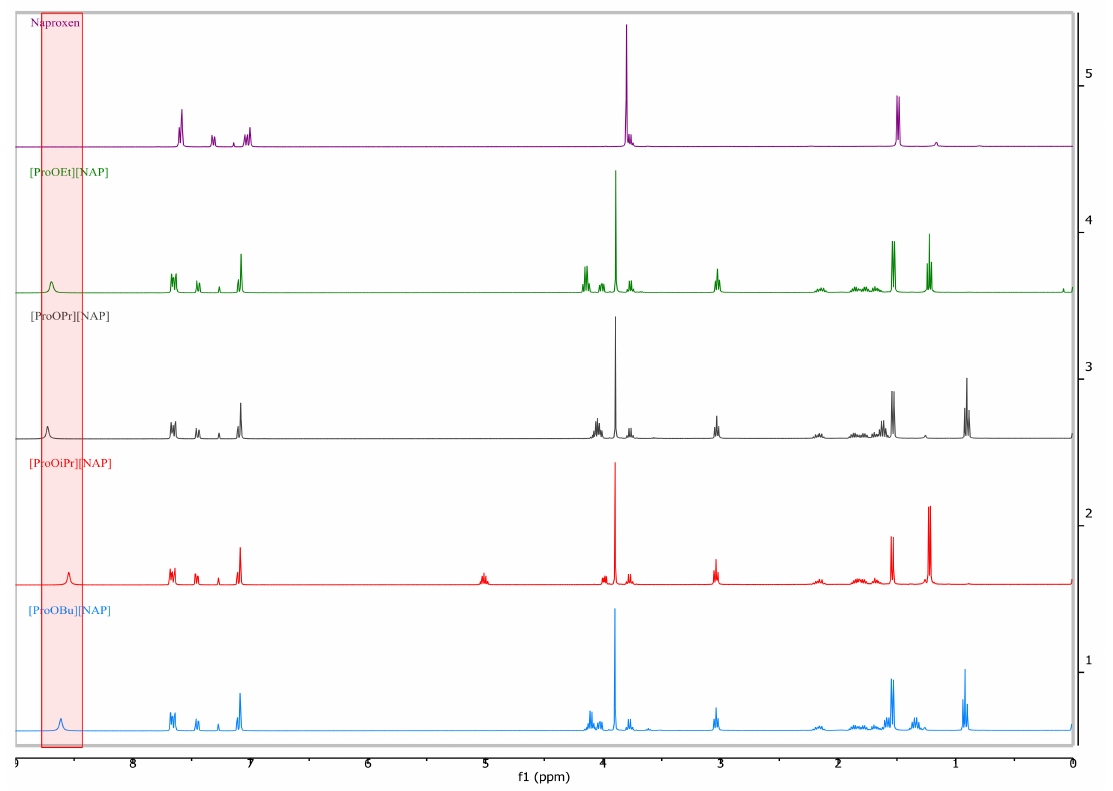
Figure 1. 1 H NMR spectra for naproxen (purple), [ProOEt][NAP] (green), [ProOPr][NAP] (black), [ProOiPr][NAP] (red), and [ProOBu][NAP] (blue) (the protonated amino group are marked in the red